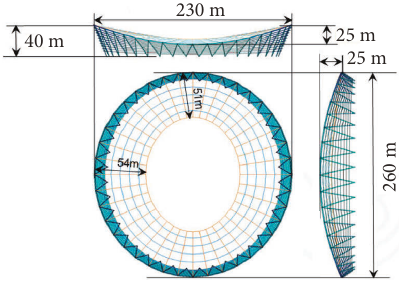
Figure 3: Main dimensions of the roof.